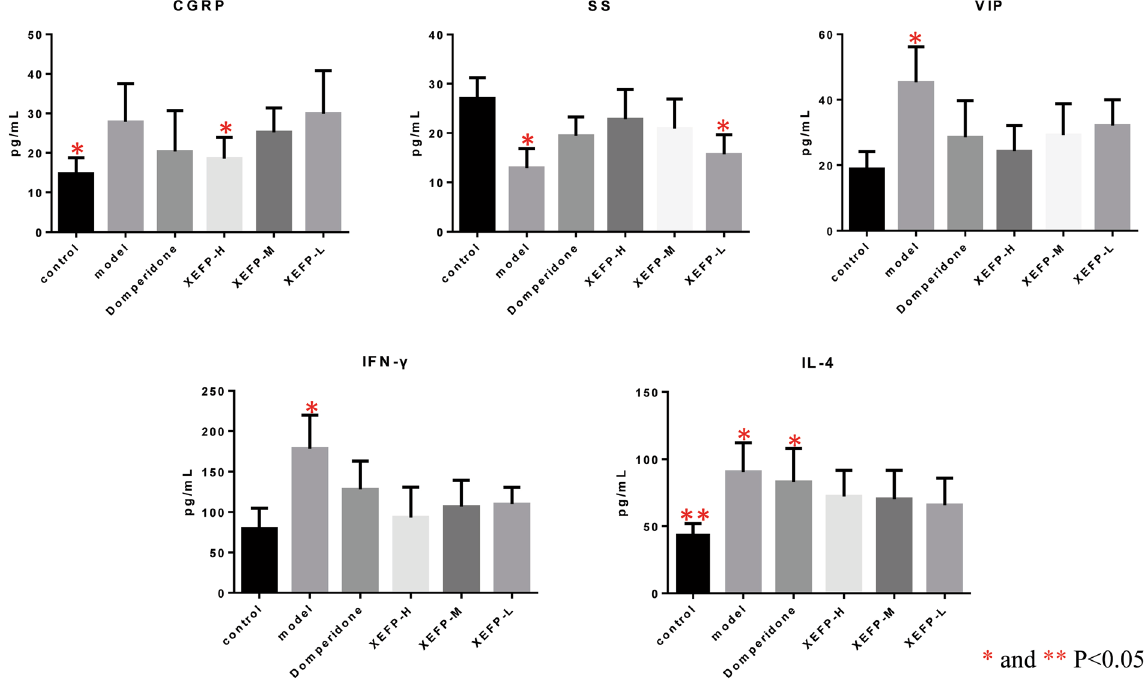
high-dosage XEFP. XEFP-M, medium-dosage XEFP. XEFP-L, low-dosage XEFP.